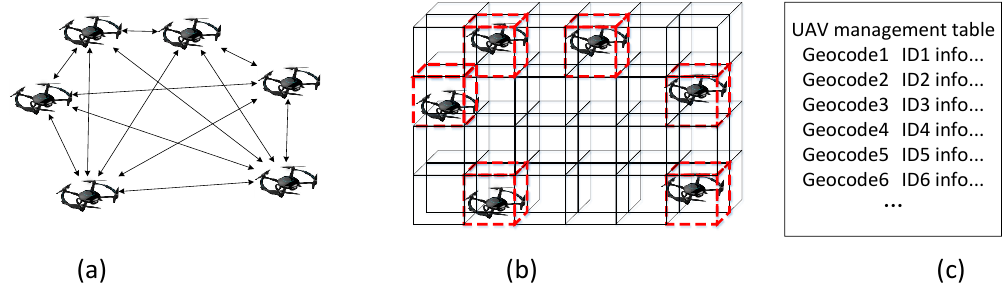
Figure 2. Traditional calculation method and spatial database-based query method for unmanned aerial vehicle (UAV) collision detection. Traditional collision detection methods depend on pairwise calculations based on three-dimensional coordinates ( a ). The calculation complexity increases rapidly as the number of UAVs increases. The grid-based method simplifies the collision detection procedure as a comparison process for regular-sized spatial grids ( b ). The grid-based method can be further advanced with a UAV management table ( c ). In the table, the GeoSOT-3D code is set as the primary key, and the collision can be detected by a straightforward